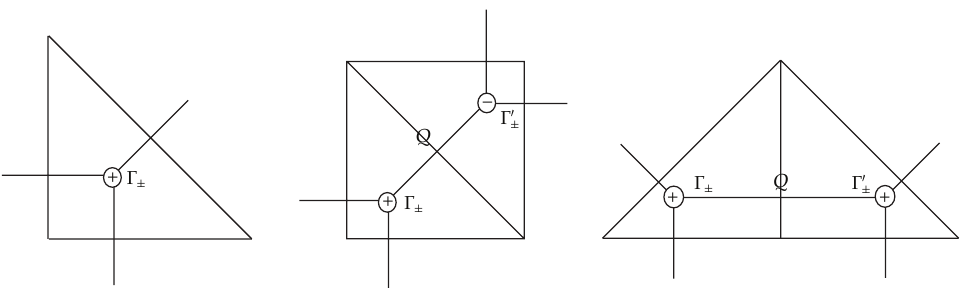
Figure 4: Toric graphs for C 3 , conifold and resolution of C 3 / Z 2